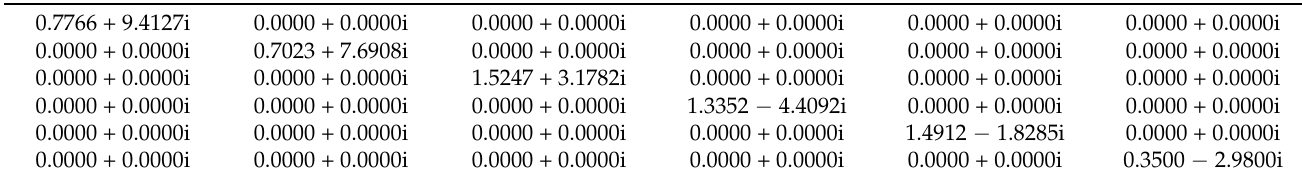
Table 6. Eigenvalues (D = λ new ).